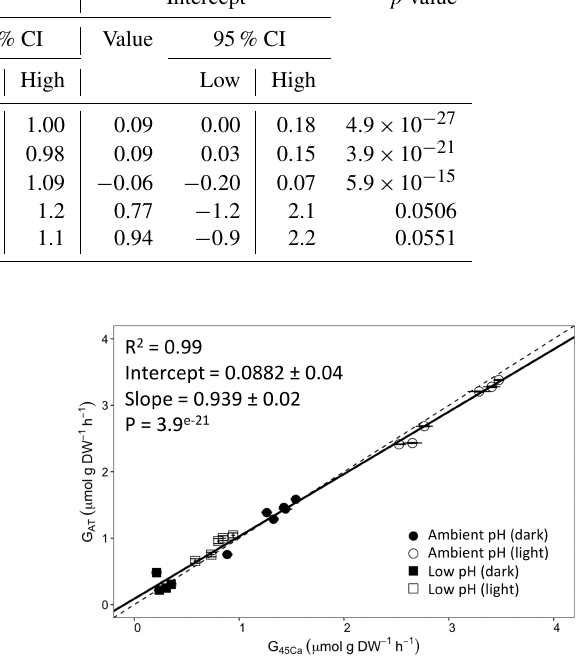
Figure 3. Calcification rates estimated based on the alkalinity anomaly technique ( G A ) as a function of calcification rates es- T timated based on the 45 Ca incorporation technique ( G 45 ). The Ca dashed line represents the 1 : 1 relationship while the full line repre- sents the model II regression relationship. Horizontal error bars rep- resent standard errors (SE) associated with the estimation of G 45 . Ca Vertical error bars representing SE associated with the estimation of T G A are too small to be visible. The corresponding dataset can be T found in Table